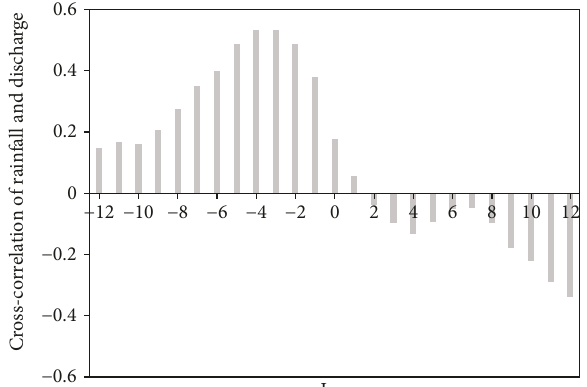
Figure 7: Cross-correlogram of cumulative monthly rainfall and average monthly discharge.